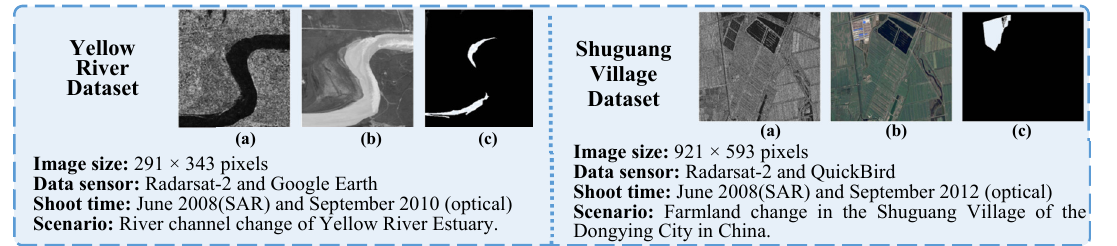
Figure 8. Dataset introduction of heterogeneous images.